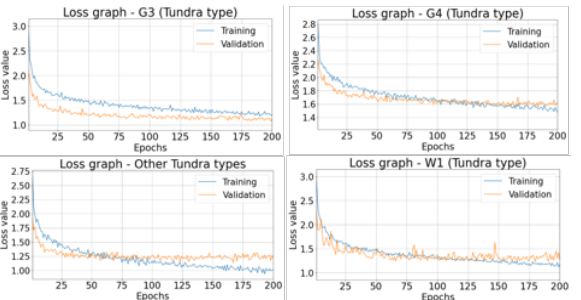
Figure 6. Loss graphs for different tundra types.